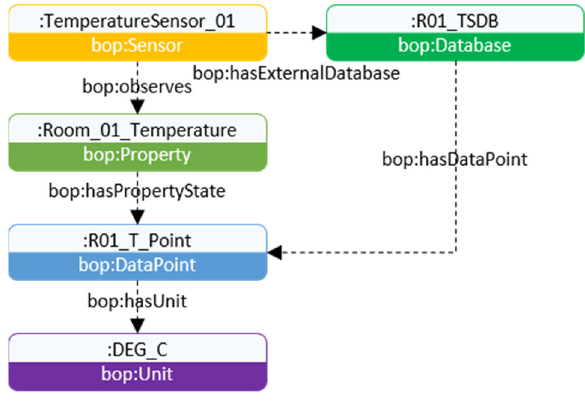
Figure 25. Aligning dynamic properties with external databases.